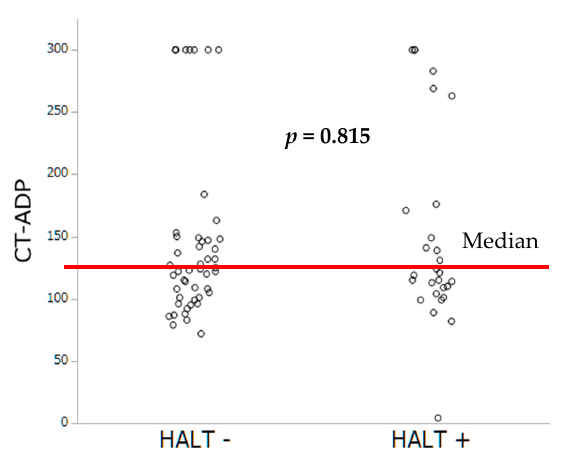
Figure 5. Occlusion time by CT-ADP according to the occurrence of HALT.